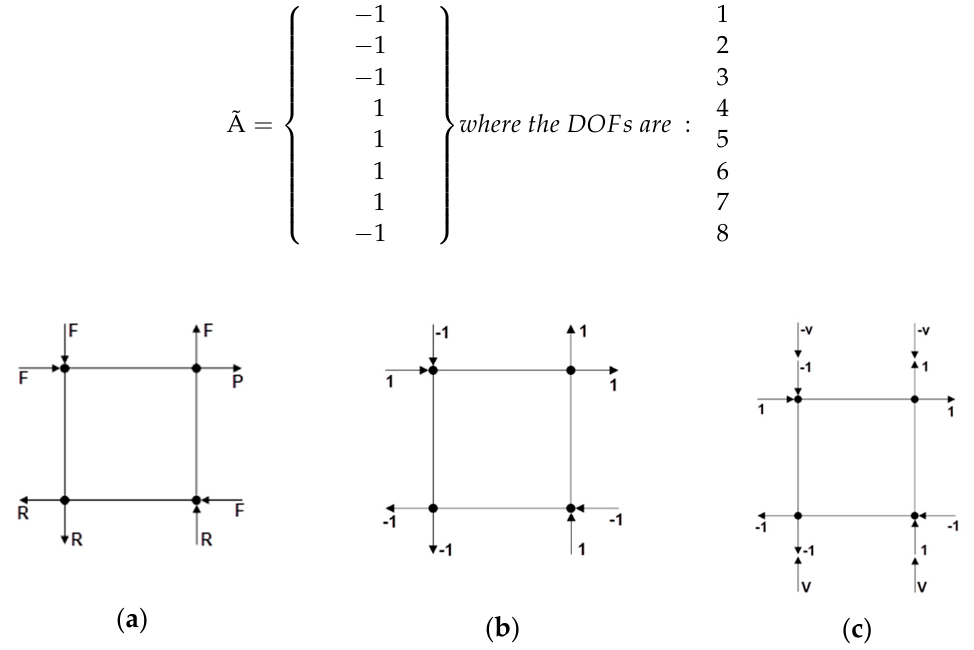
Figure 7. ( a ) Partitioned DOFs for the PLV. ( b ) Shape vector applied to the element. ( c ) Shape vector and vertical load, v, applied to element.